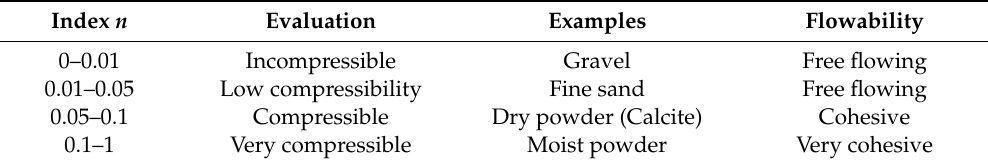
Figure 1. Compression function of a cohesive powder. Table 1. Classification of the particulate materials based on their compressibility indices [1].